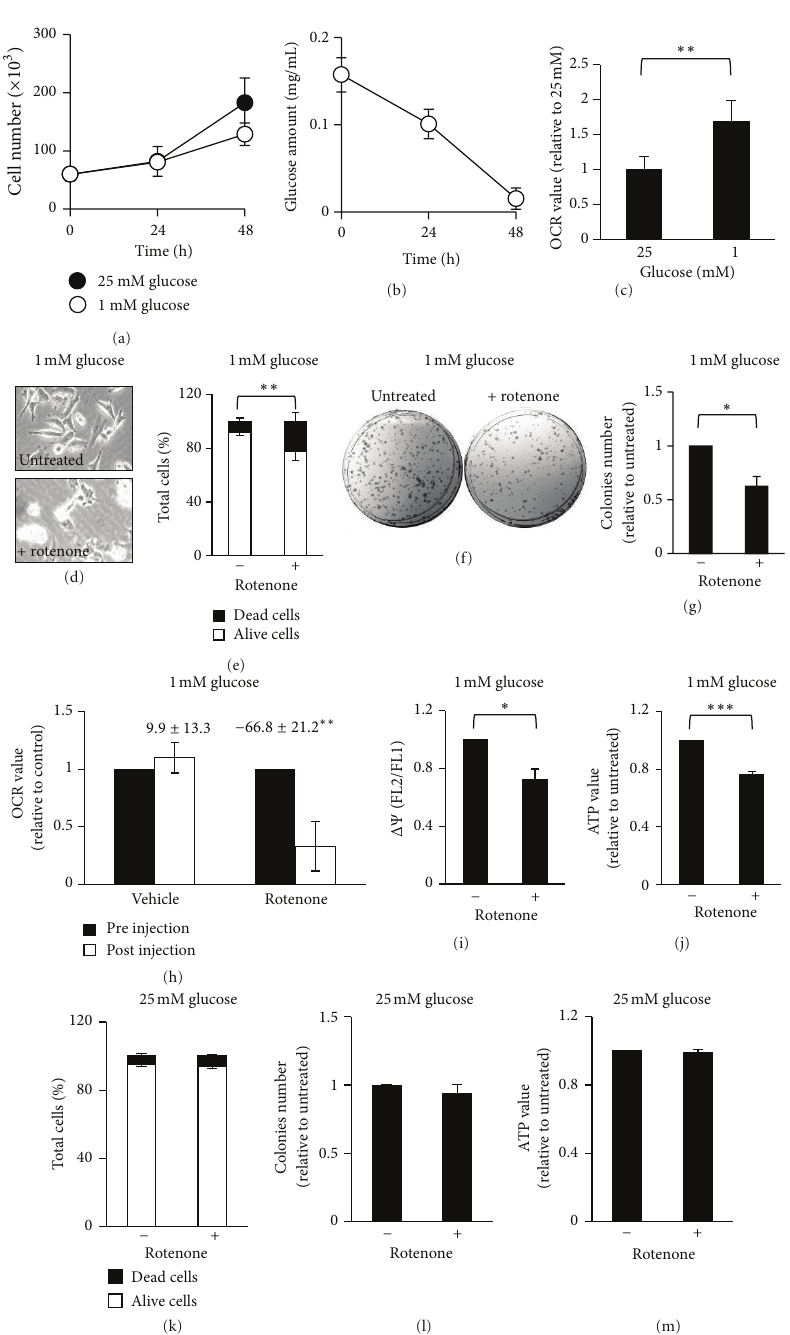
Figure 1: MDA-MB-231 cells are sensitive to rotenone in condition of glucose deprivation. (a) Proliferation curves for MDA-MB-231 cells cultured at 25 and 1mM glucose were obtained counting cells at indicated time points. (b) Glucose amount in medium of cells cultured in 1mM glucose was measured using enzymatic kit at indicated time points. (c) Basal OCR of MDA-MB-231 cells grown in 25 and 1mM glucose was determined by Seahorse XF24 analyzer; data represent the average ± s.e.m. of three independent experiments (total number of samples ≥ 10), ∗∗ 𝑃 < 0.01 (Student’s 𝑡 -test). (d)–(j) MDA-MB-231 cells cultured for 48 hours in 1mM glucose were treated for 4 hours with 3nM rotenone. After treatment, optical microscopy images (d) and viable cell count performed by using Trypan Blue Staining (e) were obtained for untreated (−) and treated (+) cells. After treatment 3×10 3 cells were also plated in normal growth medium for clonogenic assay and after ≥ 12 days colonies were stained (f) and counted (g). OCR of MDA-MB-231 cells cultured in low glucose was determined by Seahorse XF24 analyzer 30 minutes after injection of vehicle or 3nM rotenone; the percentage of OCR variation after injection is reported (h). In untreated (−) and treated (+) cells also mitochondrial potential ( ΔΨ ) indicated as ratio of mean fluorescence FL2 on mean fluorescence FL1 (see Section 2) (i) and intracellular ATP levels (j) were measured. (k)–(m) Cell count (k), clonogenic assay (l), and intracellular ATP measurement (m) were performed also in cells grown for 48 hours in 25 mM glucose and treated with rotenone as above. All data represent the average of at least three independent experiments ( ± s.d.); ∗ 𝑃 < 0.05 , ∗∗ 𝑃 < 0.01 , ∗∗∗ 𝑃 < 0.001 (Student’s 𝑡